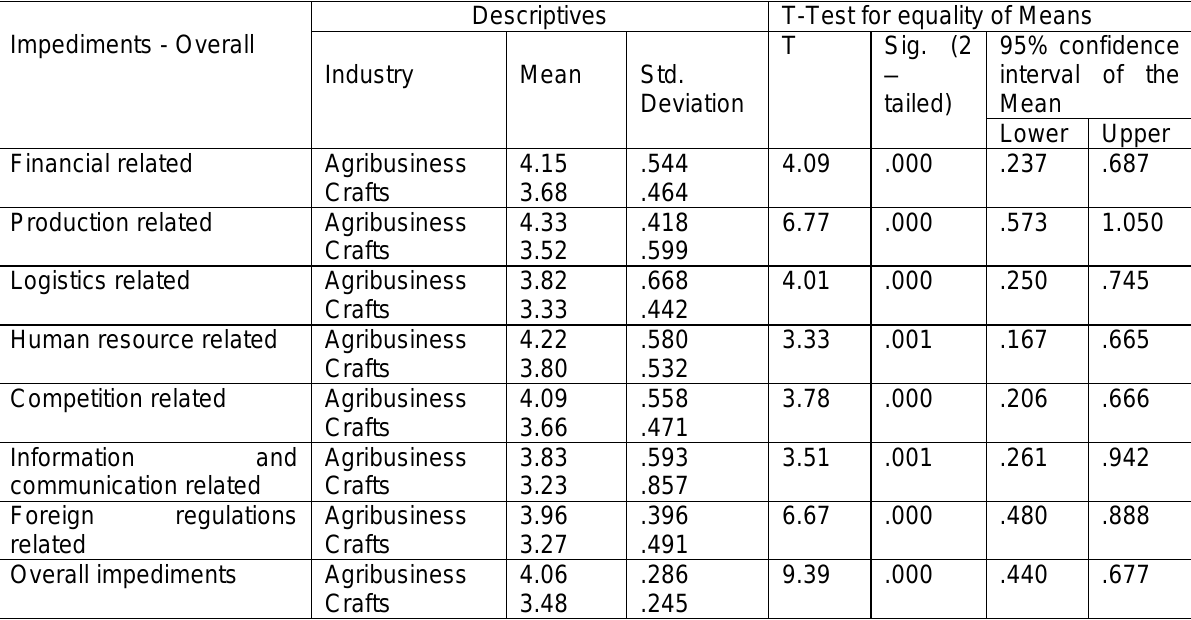
Table 3: Independent sample t-test – Industry differences Impediments - Overall